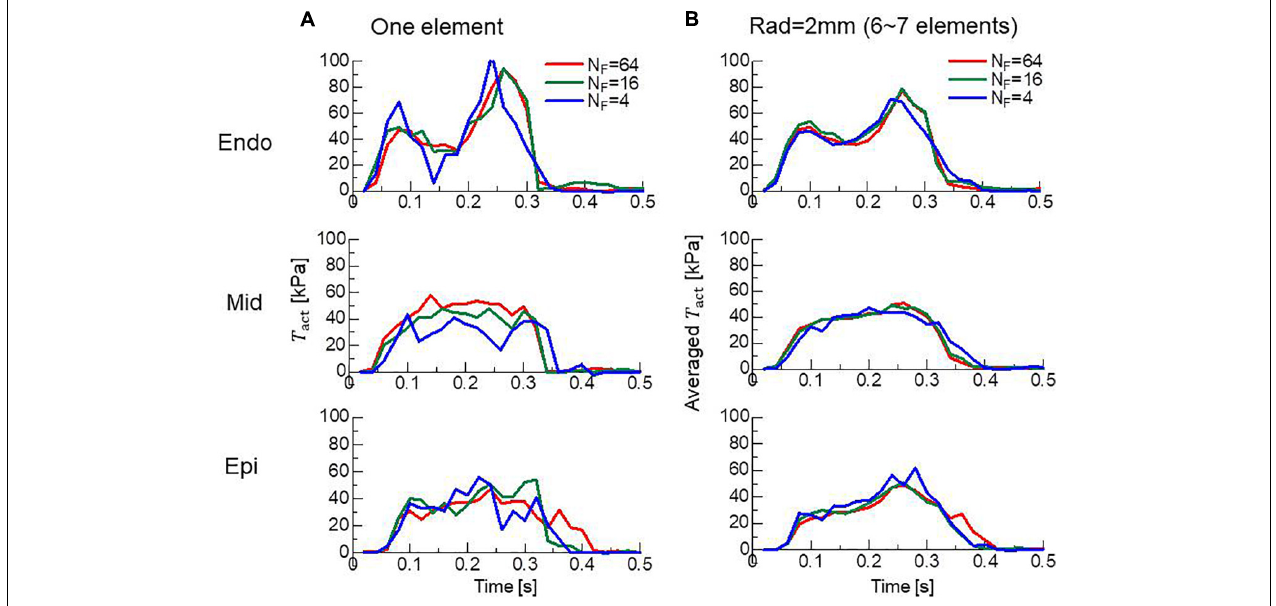
FIGURE 8 | Time transients of local active tensions at the Endo, Mid, and Epi sites in the lateral left ventricular wall. (A) The active tensions T act at a single element are plotted for N F = 4 (blue lines), 16 (green lines), and 64 (red lines). (B) The averaged values with surrounding elements within 2 mm are